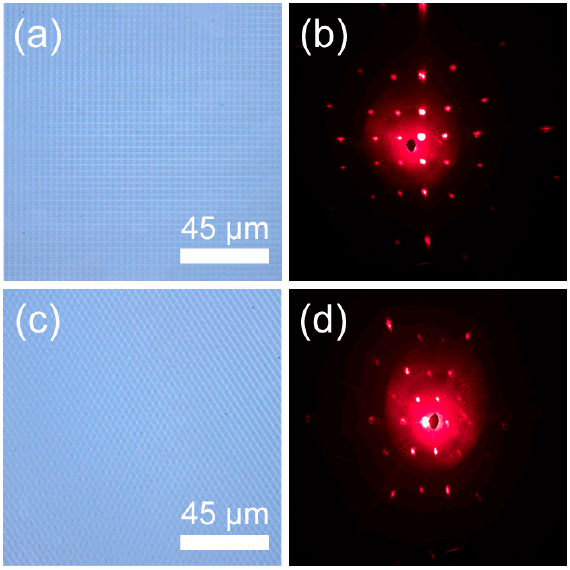
Figure 7. ( a ) Confocal photograph of square pattern; ( b ) diffraction pattern of square pattern; ( c ) confocal photograph of hexagonal pattern; ( d ) fiffraction pattern of hexagonal pattern.